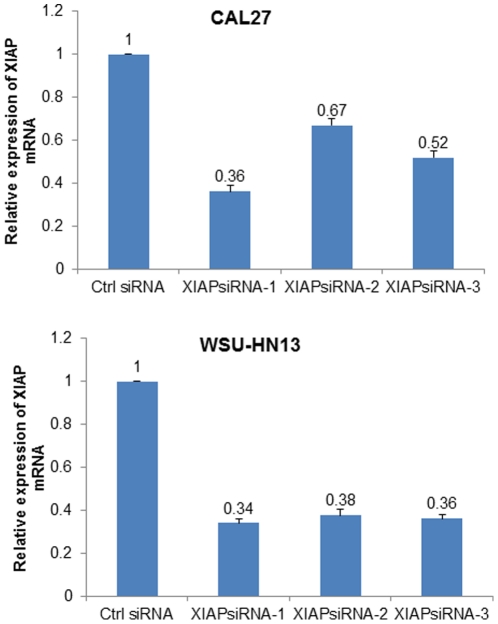
XIAP expression inhibited by siRNA.Inhibition efficacy of siRNA-1, siRNA-2 and siRNA-3 on the expression of XIAP mRNA was examined in CAL27 cell (Upper) and WSU-HN13 cell (Lower) with Real-time PCR. XIAP siRNA1 treatment group obtained near 70% reduction of XIAP mRNA expression in both cells.